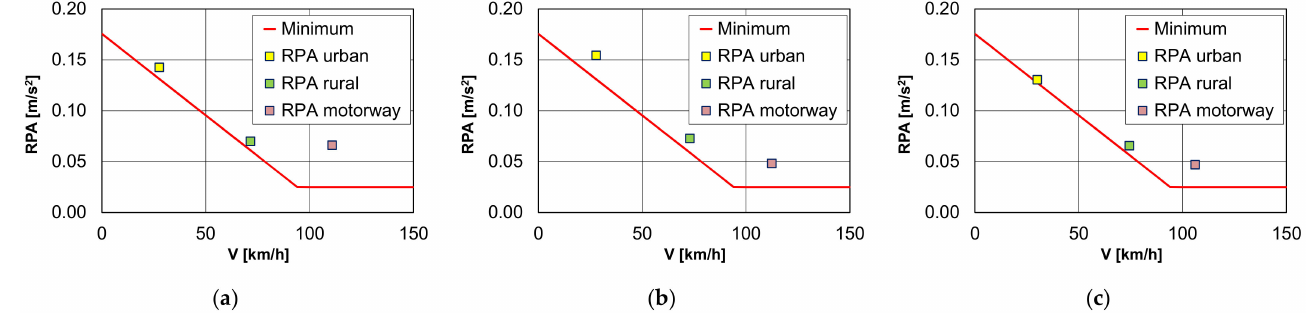
Figure 6. Evaluation of the dynamic conditions of the RDE test—the relative positive acceleration (RPA)—for a passenger vehicle with a gasoline engine ( a ), diesel engine ( b ), PHEV ( c